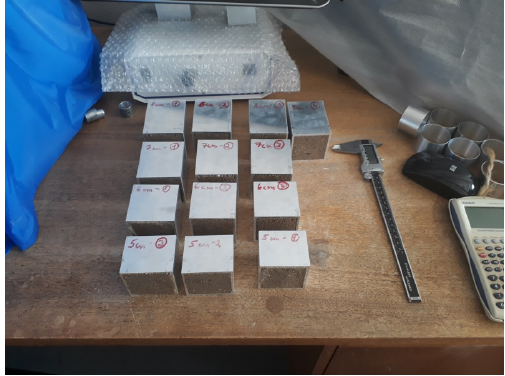
The test bodies for drying rate